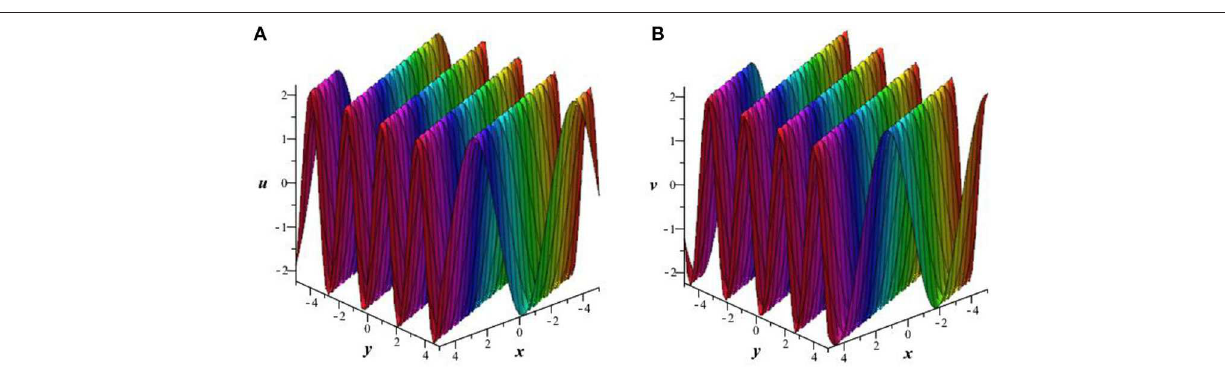
FIGURE 3 | Plot of invariant solution (42) with C 1